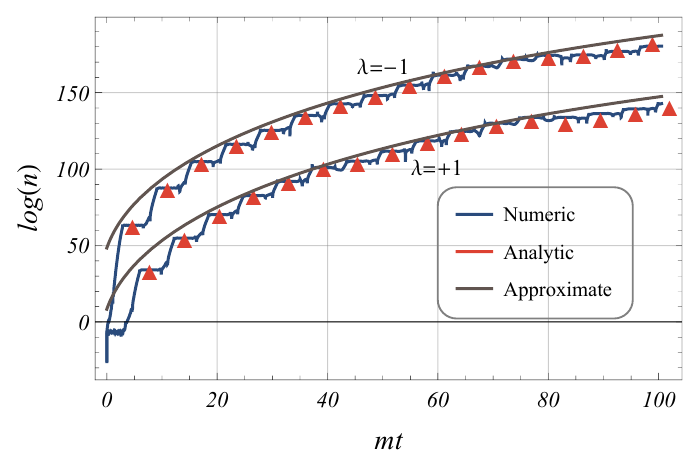
Figure 4 . Logarithm of the dark photons’ number density during the tachyonic regime as a function of time for photons (both polarizations) with wave-number k ∗ = mκ ∗ given by eq. (2.26). This is expected to be the maximum of the dark photon spectrum. For this plot we have used ϕ = 70 . The blue curve is obtained by solving eq. (2.20) numerically. The Red triangles show the result of successive scattering matrix method in eq. (2.35). The gray curve is the approximate formula of eq.